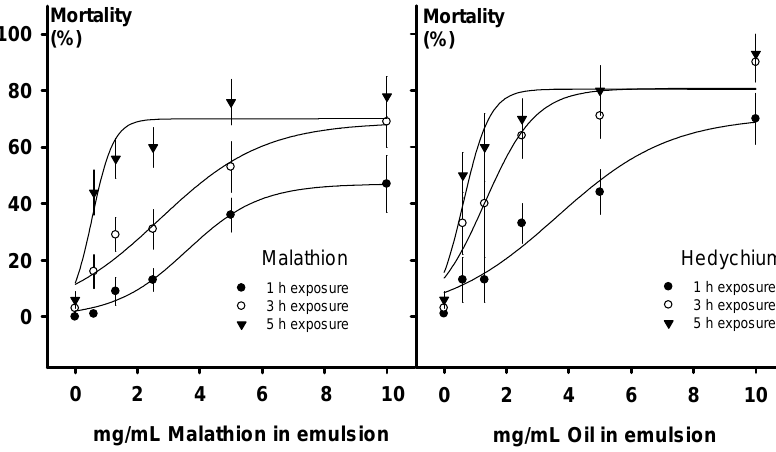
Figure 1. Percentage mortality for adult azalea lace bugs, Stephanitis pyrioides (Scott) after they were exposed for 1, 3, and 5 h to six concentrations of Hedychium oil or malathion (0.0, 0.6, 1.3, 2.5, 5.0, and 10.0 mg/mL).